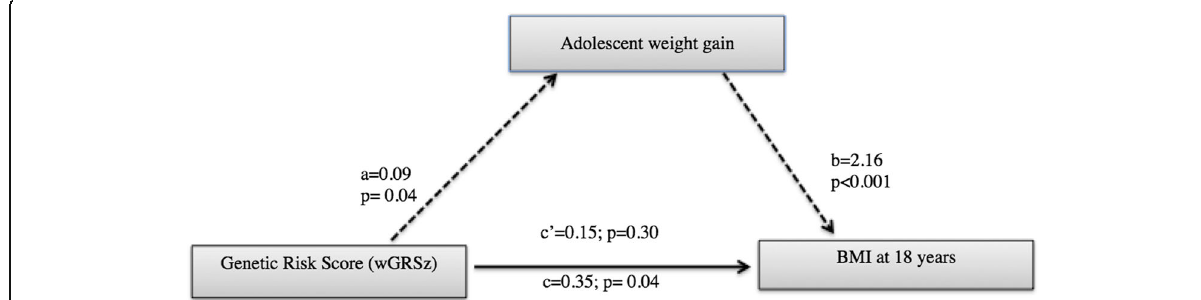
Fig. 2 Impact of weighted genetic risk score (wGRSz) on BMI at 18 years via adolescent conditional relative weight gain. Notes: Path a is the direct effect of the wGRSz on mediator (adolescent weight gain). Path b is the mediator ’ s effect on the outcome (BMI at 18 years) eliminating the effect of wGRSz. The total effect of wGRSz on BMI at 18 years is c = c ’ + a × b , where a × b is the indirect effect of wGRSz on BMI at 18 years via adolescent weight